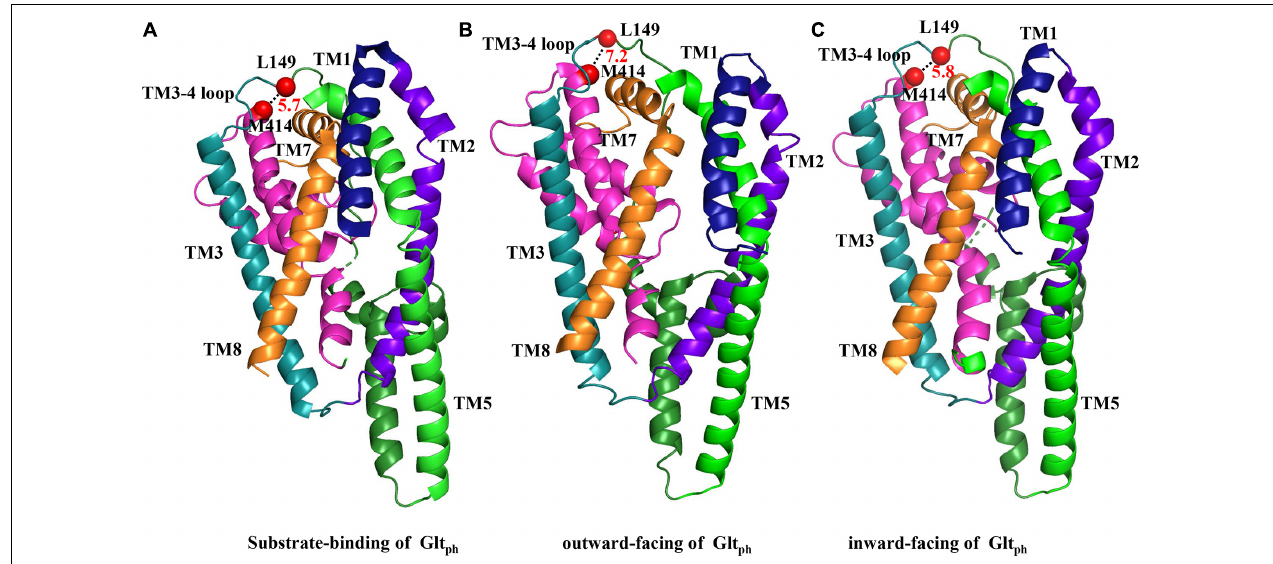
FIGURE 6 | Substrate-binding and outward- and inward-facing structures of Glt Ph . The crystallized substrate-binding (A) , outward-facing (B) , and inward-facing (C) forms of Glt Ph are shown (respective PDB ID codes 1XFH, 2NWW, and 2NWX) and were aligned as indicated in figure. Segments that are not labeled are TM4 (dark green), and HP2 (pink). TM6 and HP1 were removed for the facilitation of observation. The distances between the two amino acids are represented by black dashed lines between two red dots, which indicate the spatial locations of L149 and M414,